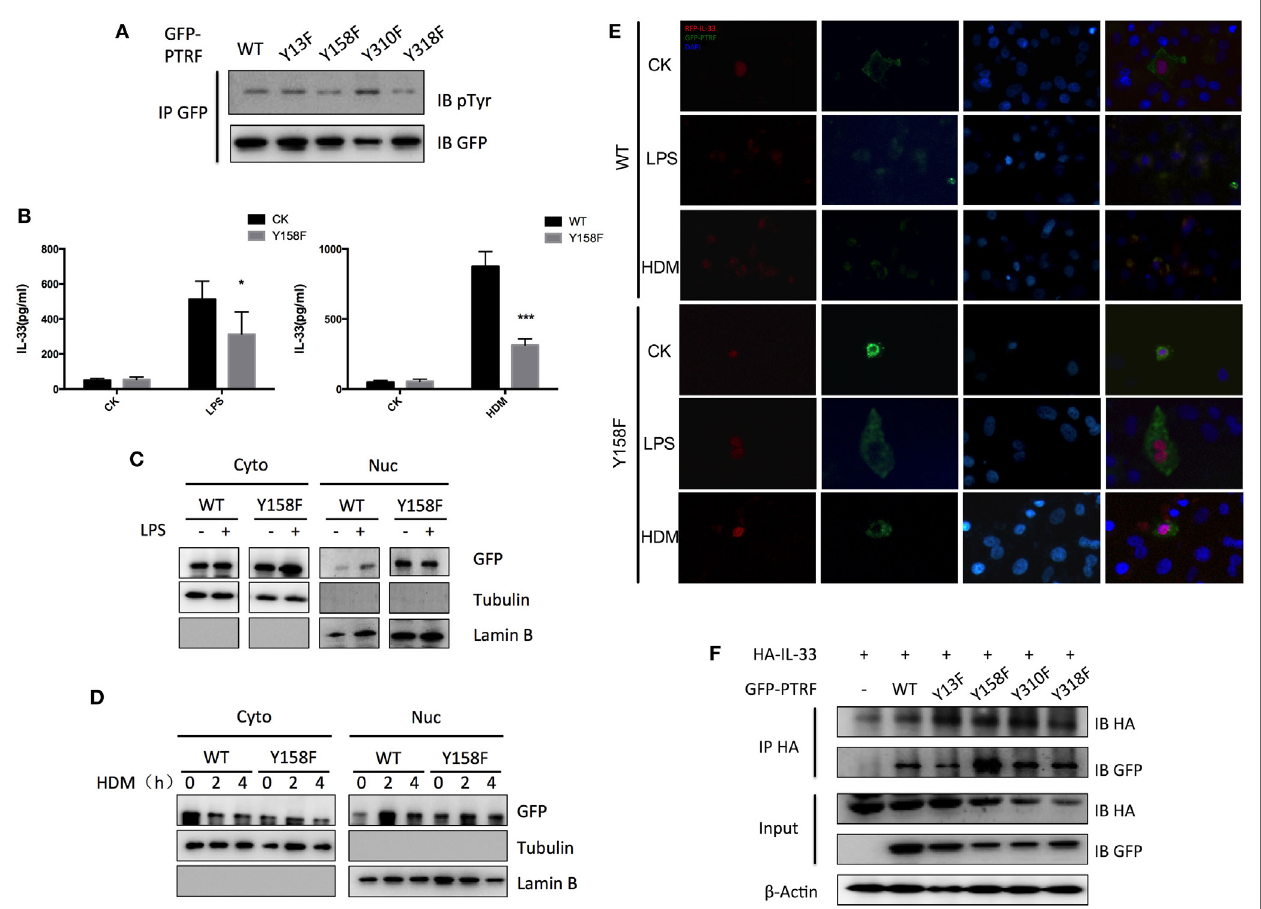
FigUre 6 | Phosphorylation of polymerase I and transcript release factor (PTRF) critically controls IL-33 release. (a) Whole cell lysates from wild type PTRF and various single tyrosine mutants (Y13F; Y158F; Y310F; Y318F) transfected HBE cell were immunoprecipitated with GFP antibody followed by SDS-PAGE and blotted with indicated antibodies. (B) IL-33 level of culture supernatant of wild type PTRF and Y158F mutated PTRF transfected HBE cell with or without LPS (1 ng/µl) or HDM (30 µg/µl) treatment. (c) Nuclear and cytoplasmic protein extraction from wild type PTRF and Y158F mutated PTRF transfected HBE cell with or without LPS (1 ng/µl) treatment were blotted with indicated antibodies. (D) Nuclear and cytoplasmic protein extraction from wild type PTRF and PTRF Y158F mutant transfected HBE cell with or without HDM (30 µg/µl) treatment were blotted with indicated antibodies. (e) Representative images of IL-33 (red) and PTRF (green) immunofluorescence of wide type PTRF or Y158F mutated PTRF transfected HBE with or without LPS (1 ng/µl) or HDM (30 µg/µl) treatment. (F) Whole cell lysates from wild type PTRF and Y158F mutated PTRF transfected HBE cell were immunoprecipitated with anti-HA antibody followed by SDS-PAGE and blotted with indicated antibodies. * p < 0.05, ** p < 0.01, *** p < 0.001, as determined by Student’s t